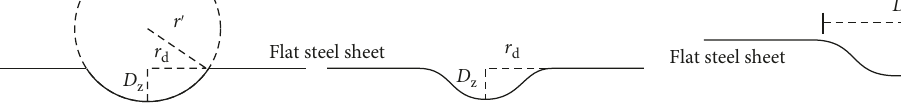
Figure 2: Cross section of dent depth and diameter.